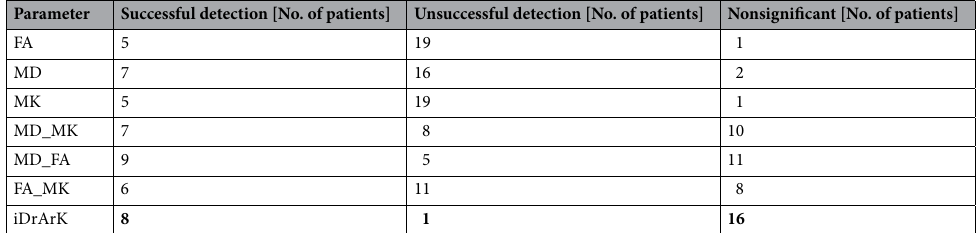
Table 2. Number of subjects with successful ( PPV ≥0.5), unsuccessful ( PPV < 0.5), or (3) nonsignificant (no statistically significant results) detection, when using FA/MD/MK/MD_MK/MD_FA/FA_MK/iDrArK maps restricted by MK-LAI results. FA fractional anisotropy, MD mean diffusivity, MK mean kurtosis, iDrArK increased mean Diffusivity, reduced fractional Anisotropy, reduced mean Kurtosis, MK‑LAI Lobar asymmetry index calculated from mean kurtosis values. The row in BOLDs denotes iDrArK - the index with the highest EZ detection